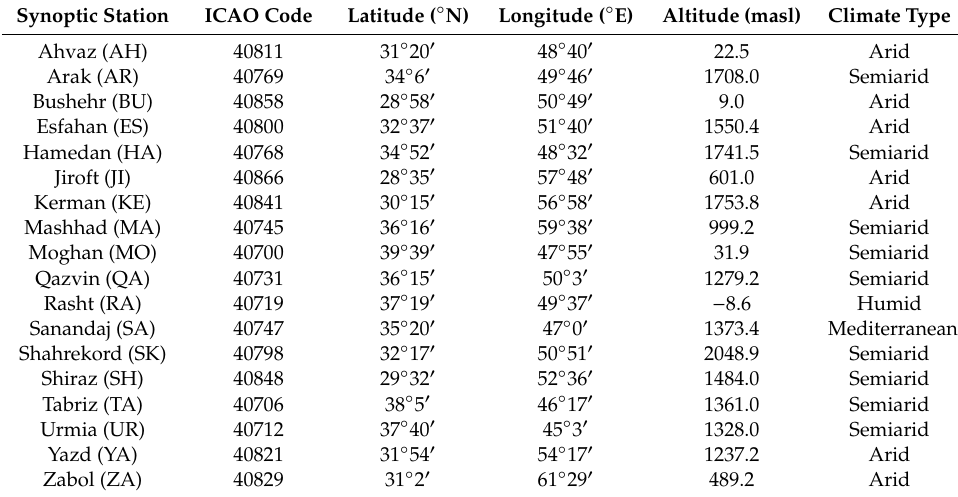
Table 1. Location, altitude, and climate of the 18 study